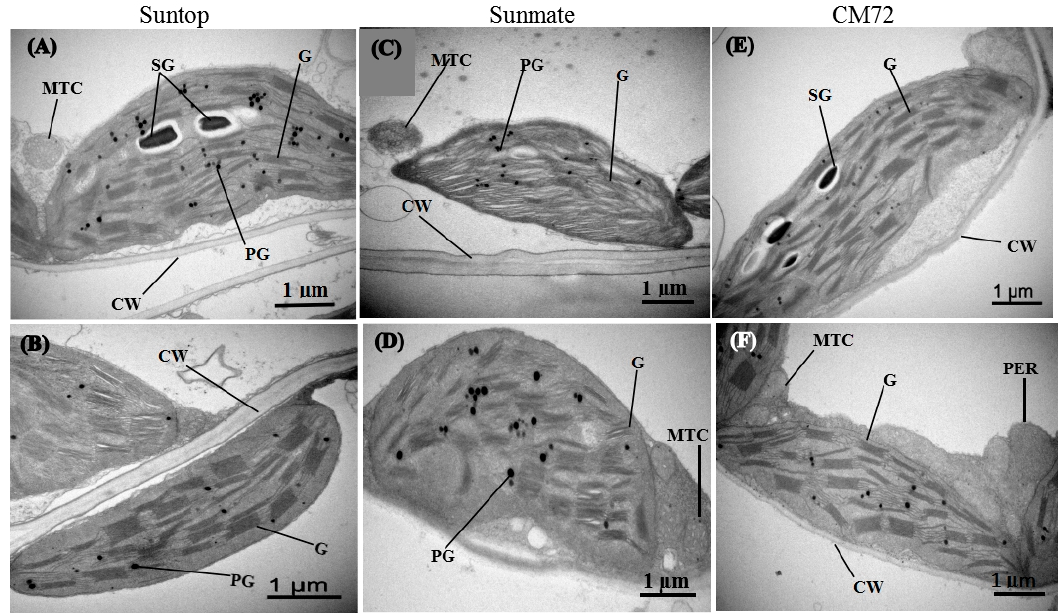
Figure 6. Transmission electron micrographs of chloroplasts of leaves of Suntop ( A , B ), Sunmate ( C , D ), and CM72 ( E , F ) under control (top panel) and 100 mM NaCl (bottom panel). CW, cell wall; G, grana; MTC, mitochondria; PG, plastoglobuli; SG, starch grains.